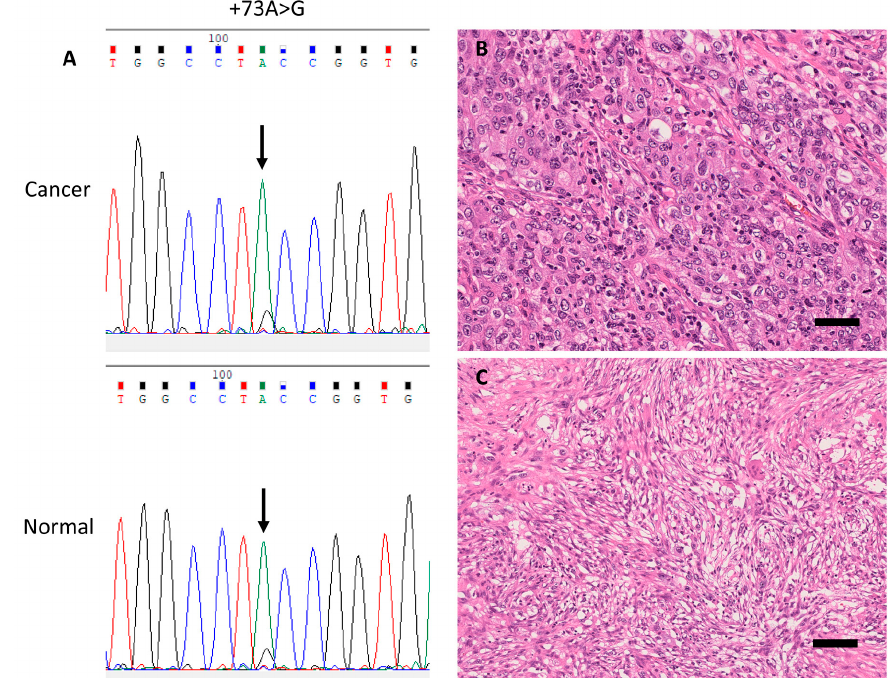
Figure 4. Representative case with a germline single-nucleotide variant (SNV) in the rDNA promoter (case 3). ( A ) Electropherograms of germline SNV +73A>G from corresponding cancer (upper panel) and normal (lower panel) tissue samples. (B ) Representative histopathological images of this pleomorphic carcinoma case (H&E stain) showing a solid predominant phenotype, and ( C ) sarcomatoid component composed of pleomorphic spindle cells. Scale bar, 100 μ m.